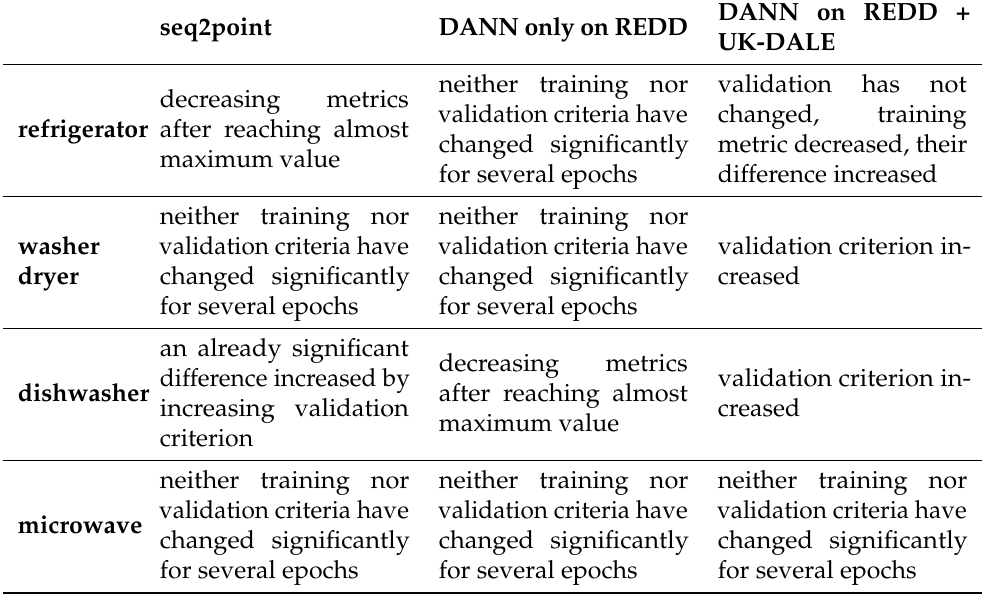
Table 7. Explanations for training